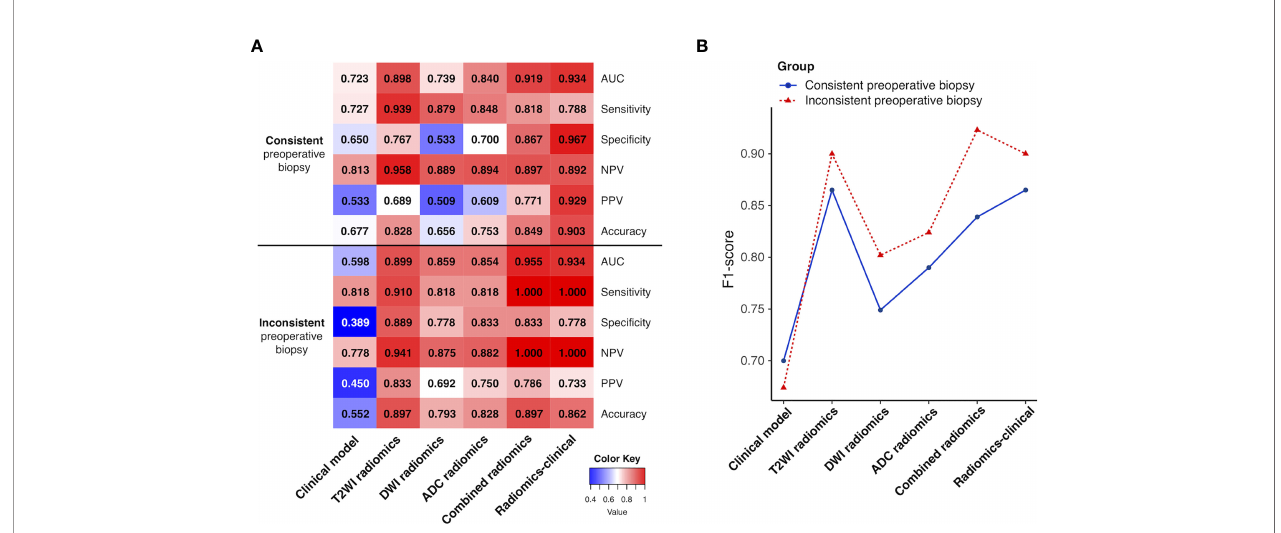
FIGURE 6 | (A) Heatmap showing the models ’ performance in the subgroups of patients with preoperative endometrial biopsy consistent and inconsistent with postoperative pathologic data. A deeper red indicates a larger value. (B) Line chart of the F1-score of the models in two subgroups. NPV, negative predictive value; PPV, positive predictive